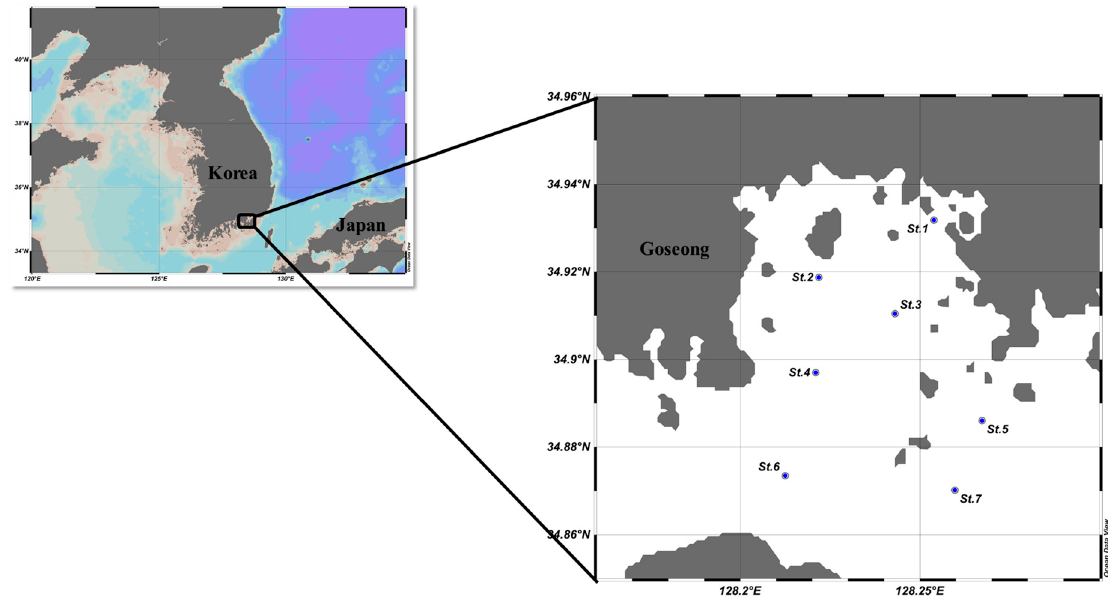
Figure 1. Sampling stations in Jaran Bay, South Sea of Korea.